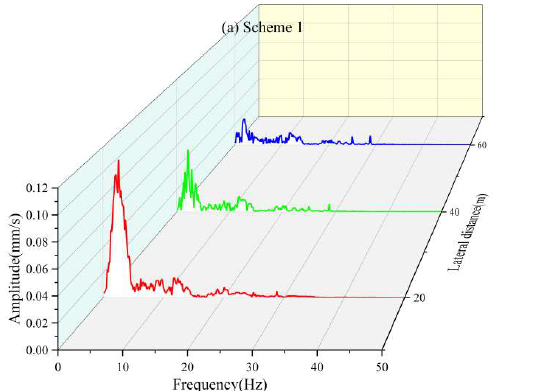
Figure 9. Frequency–domain curve of longitudinal decay of vibration velocity.